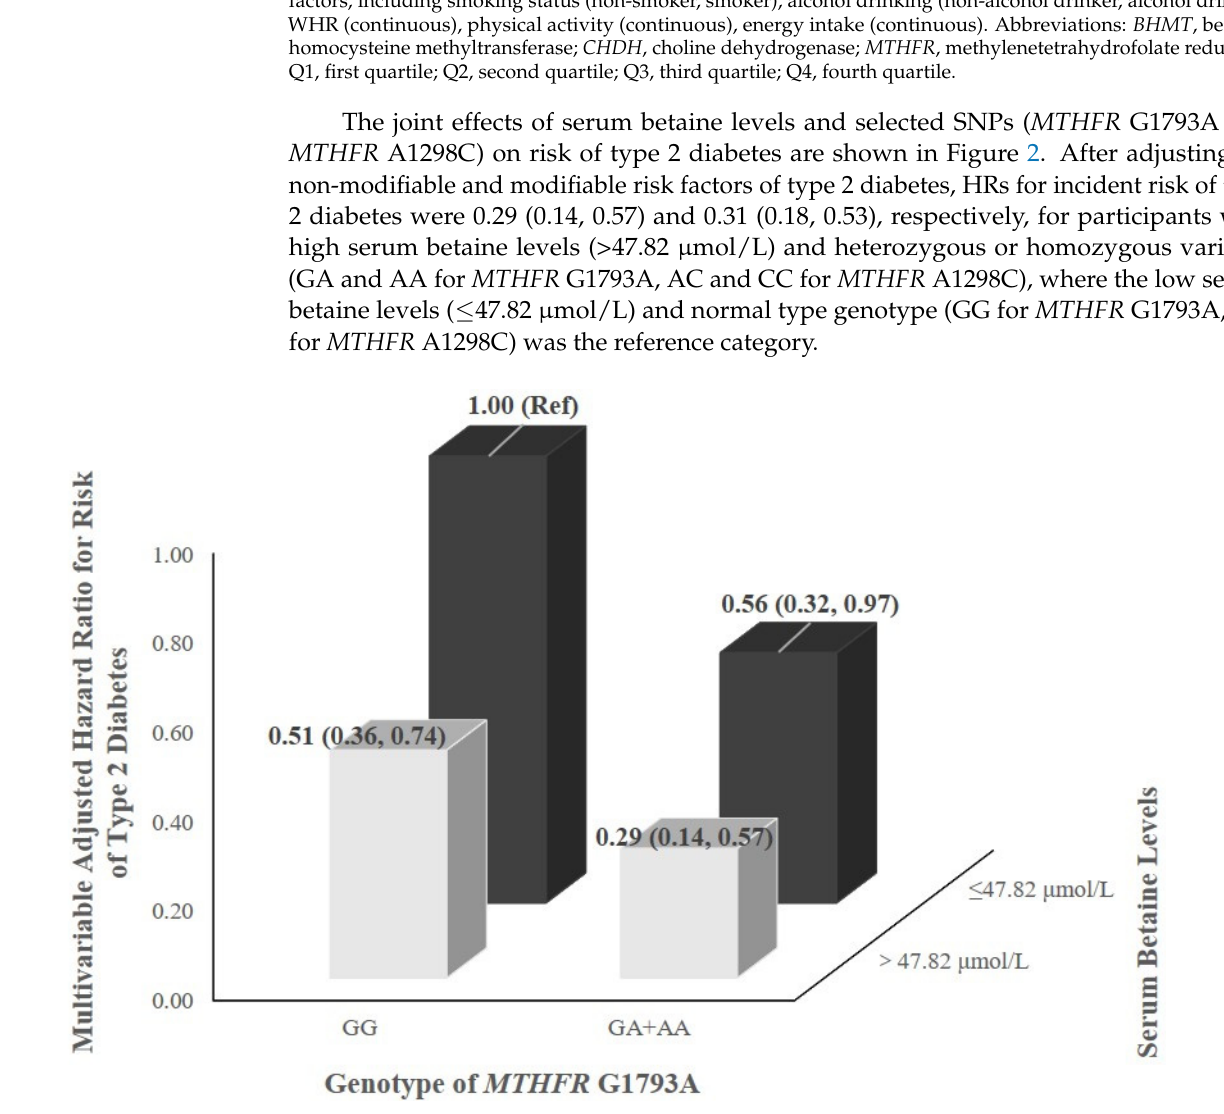
Figure 2. Interaction of serum betaine and genotypes of MTHFR G1793A or A1298C on the associa- tion with risk of type 2 diabetes in the Guangzhou Nutrition and Health Study.